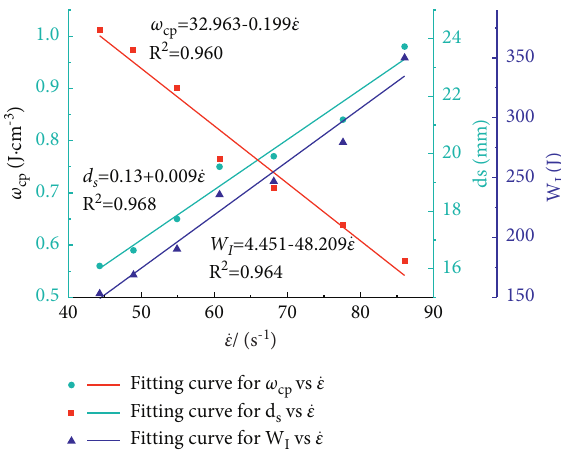
Fitting curve for ω cp vs ε Fitting curve for d s vs ε Fitting curve for W I vs ε Figure 12: Curves of specific energy absorption, average frag- mentation, and incident energy at different strain rates.